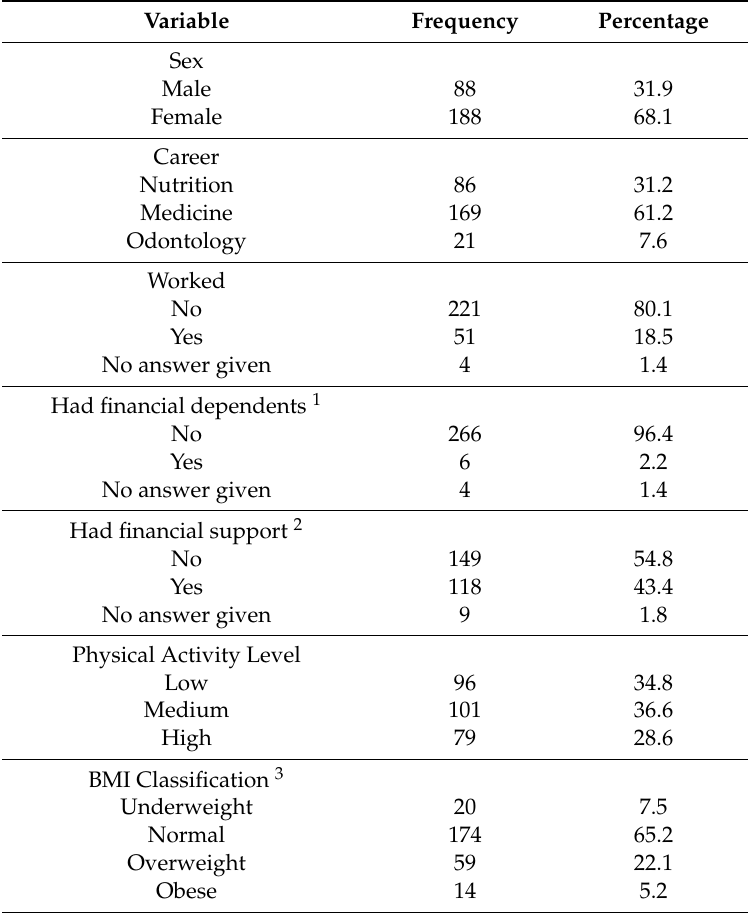
Table 2. Table 2. General characteristics of the population ( n =